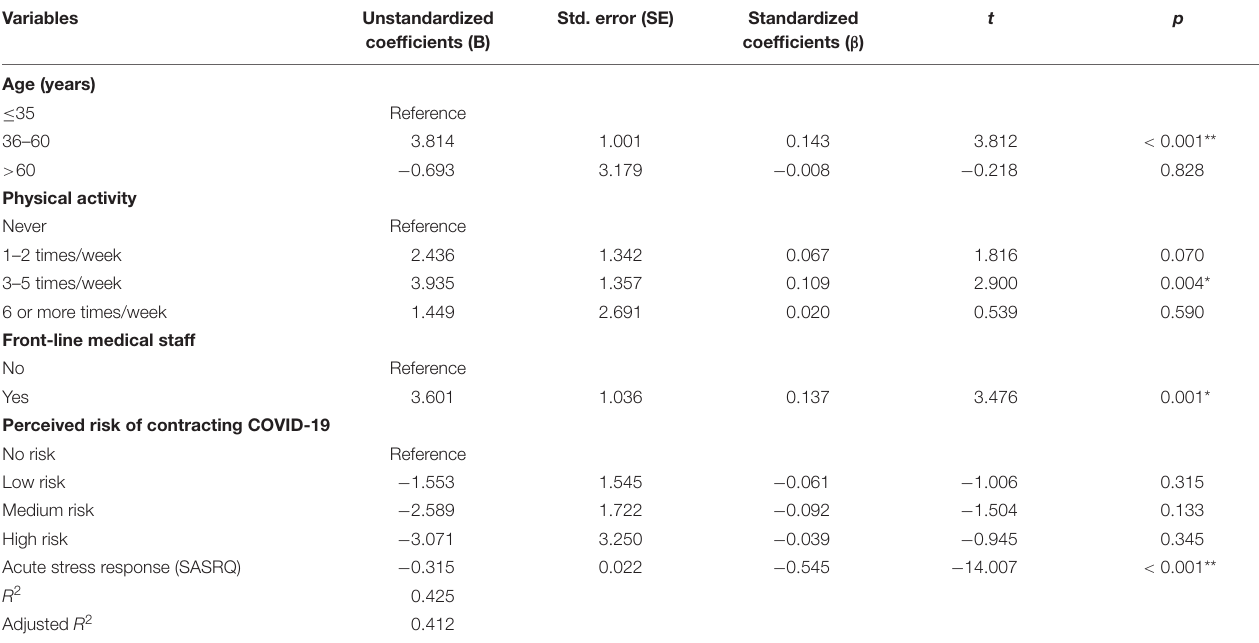
TABLE 4 | Multiple linear regression analysis of the influencing factors of quality of